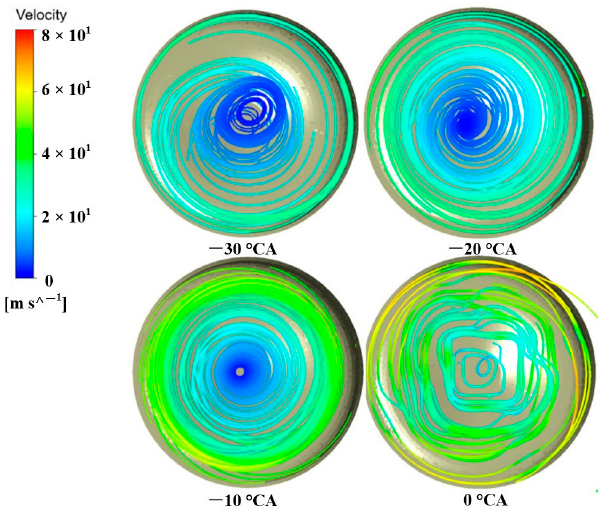
Figure 7. Swirl Velocity in Combustion Chamber.